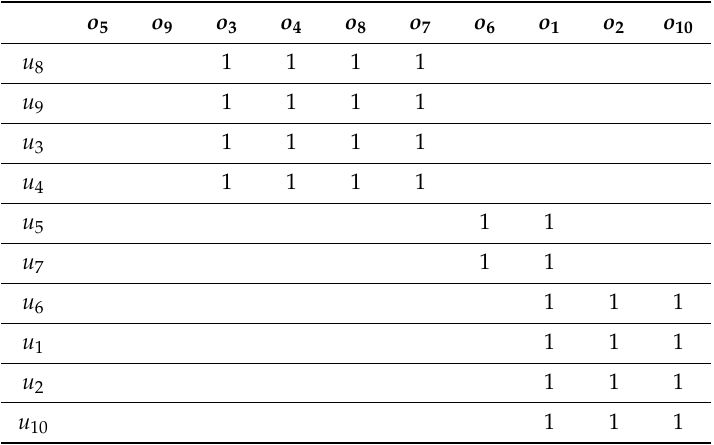
Table 11. Step 4 for